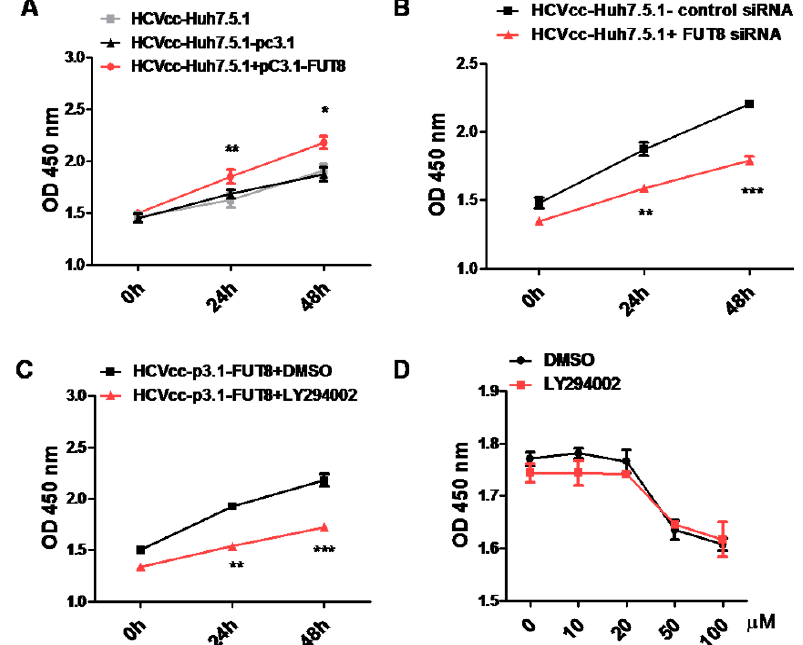
Figure 9. FUT8 promotes HCV-infected cell proliferation through PI3K. The effects of the overexpression ( A ) or silencing ( B ) of FUT8 on the proliferation of HCV-infected Huh7.5.1 cells were detected by CCK8 assay at different time points. ( C ) The effect of PI3K inhibitor LY294002 on the proliferation of HCV-infected Huh7.5.1 cells was detected by CCK8 assay at different time points. ( D ) Huh7.5.1 cells were pretreated with different concentrations of LY294002 or DMSO control reagent for 2 h, then washed and detected after 48 h incubation by CCK8 assay.